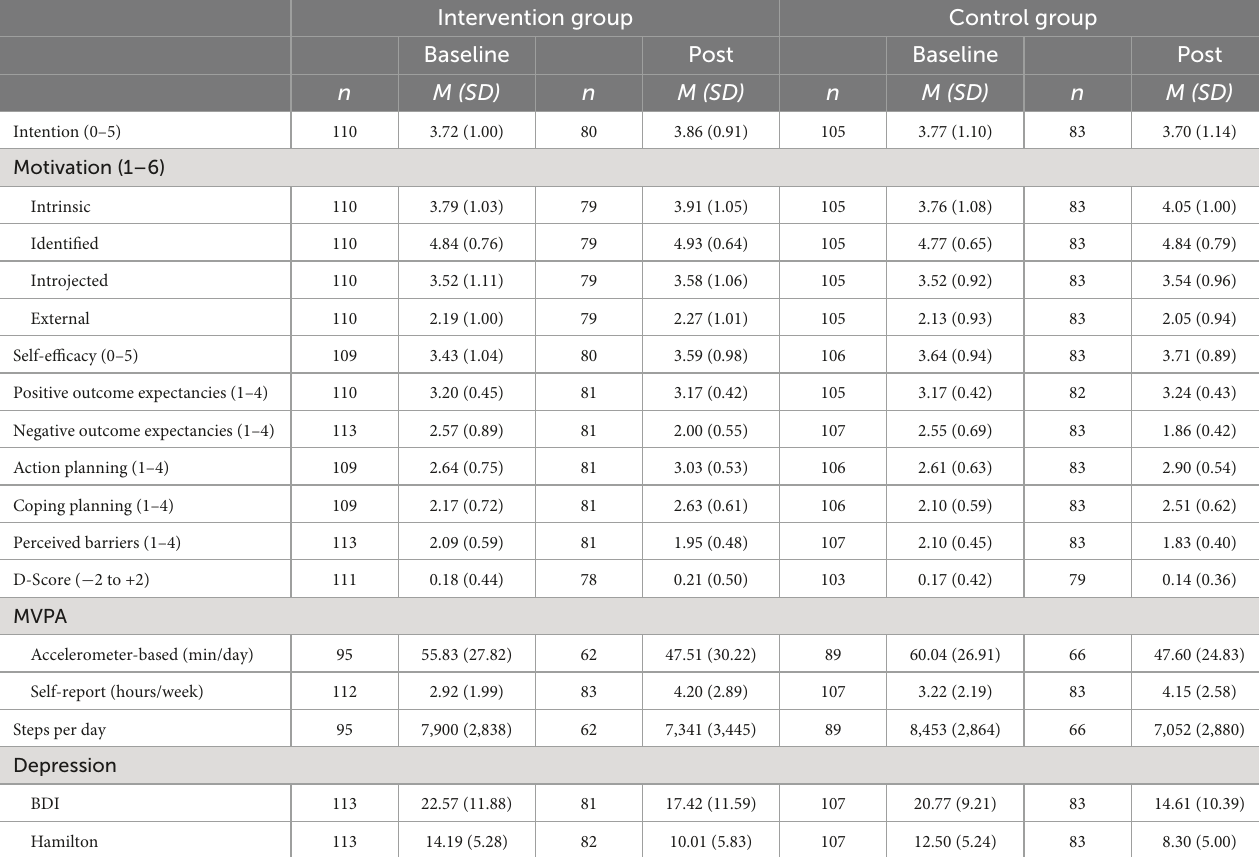
TABLE 2 Descriptive statistics of main variables at baseline and post